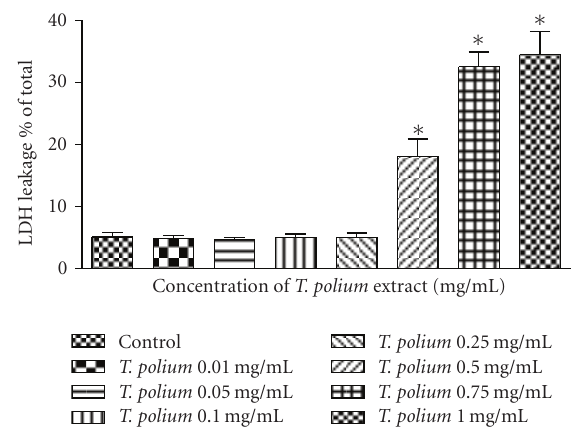
Figure 2: E ff ect of increasing concentrations of an aqueous extract of T. polium on membrane integrity in HepG2 cultured cells using the LDH assay. Data are presented as mean ± standard deviation. Sample size ( n ) = 7. ∗ p < 0 . 01 represents the significance of the di ff erence from the control. All data are presented as a percentage of the total (100%).